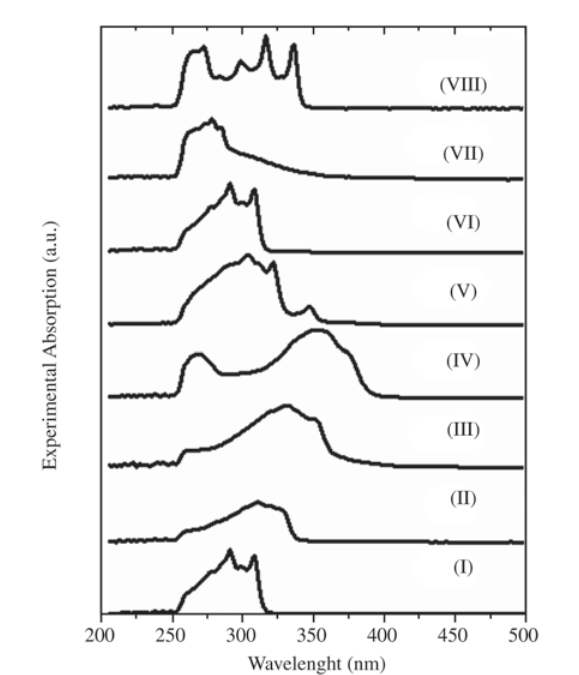
Figure 2 . Experimental UV-vis absorption spectra of alkynes I-VIII (Table 1) in hexane (see methodology).